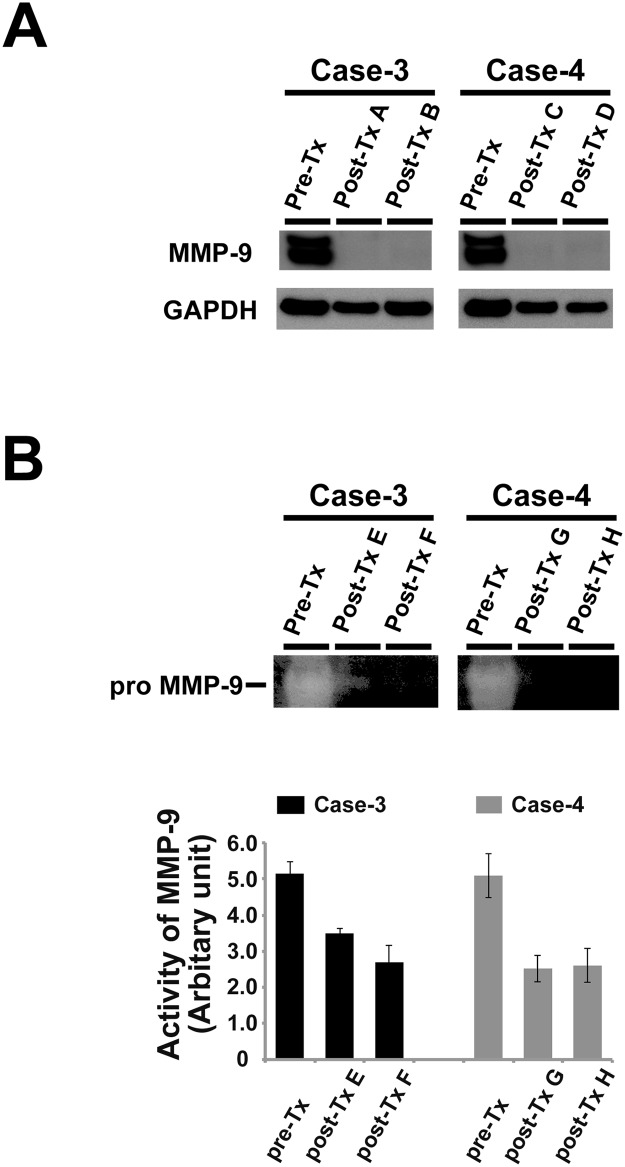
A validation study on the expression and activity of MMP-9 in the validation set.(A) In the Western blot analysis, the expression levels of MMP-9 were found to decrease in the post-Tx samples in comparison to the pre-Tx expression levels in cases 3 and 4. (B) In the zymographic analysis, the gelatinolytic activity of MMP-9 was decreased in the post-Tx samples in comparison to the pre-Tx samples in cases 3 and 4 (upper panel). The bar graph shows the quantitative results of the zymographic analysis (lower panel).